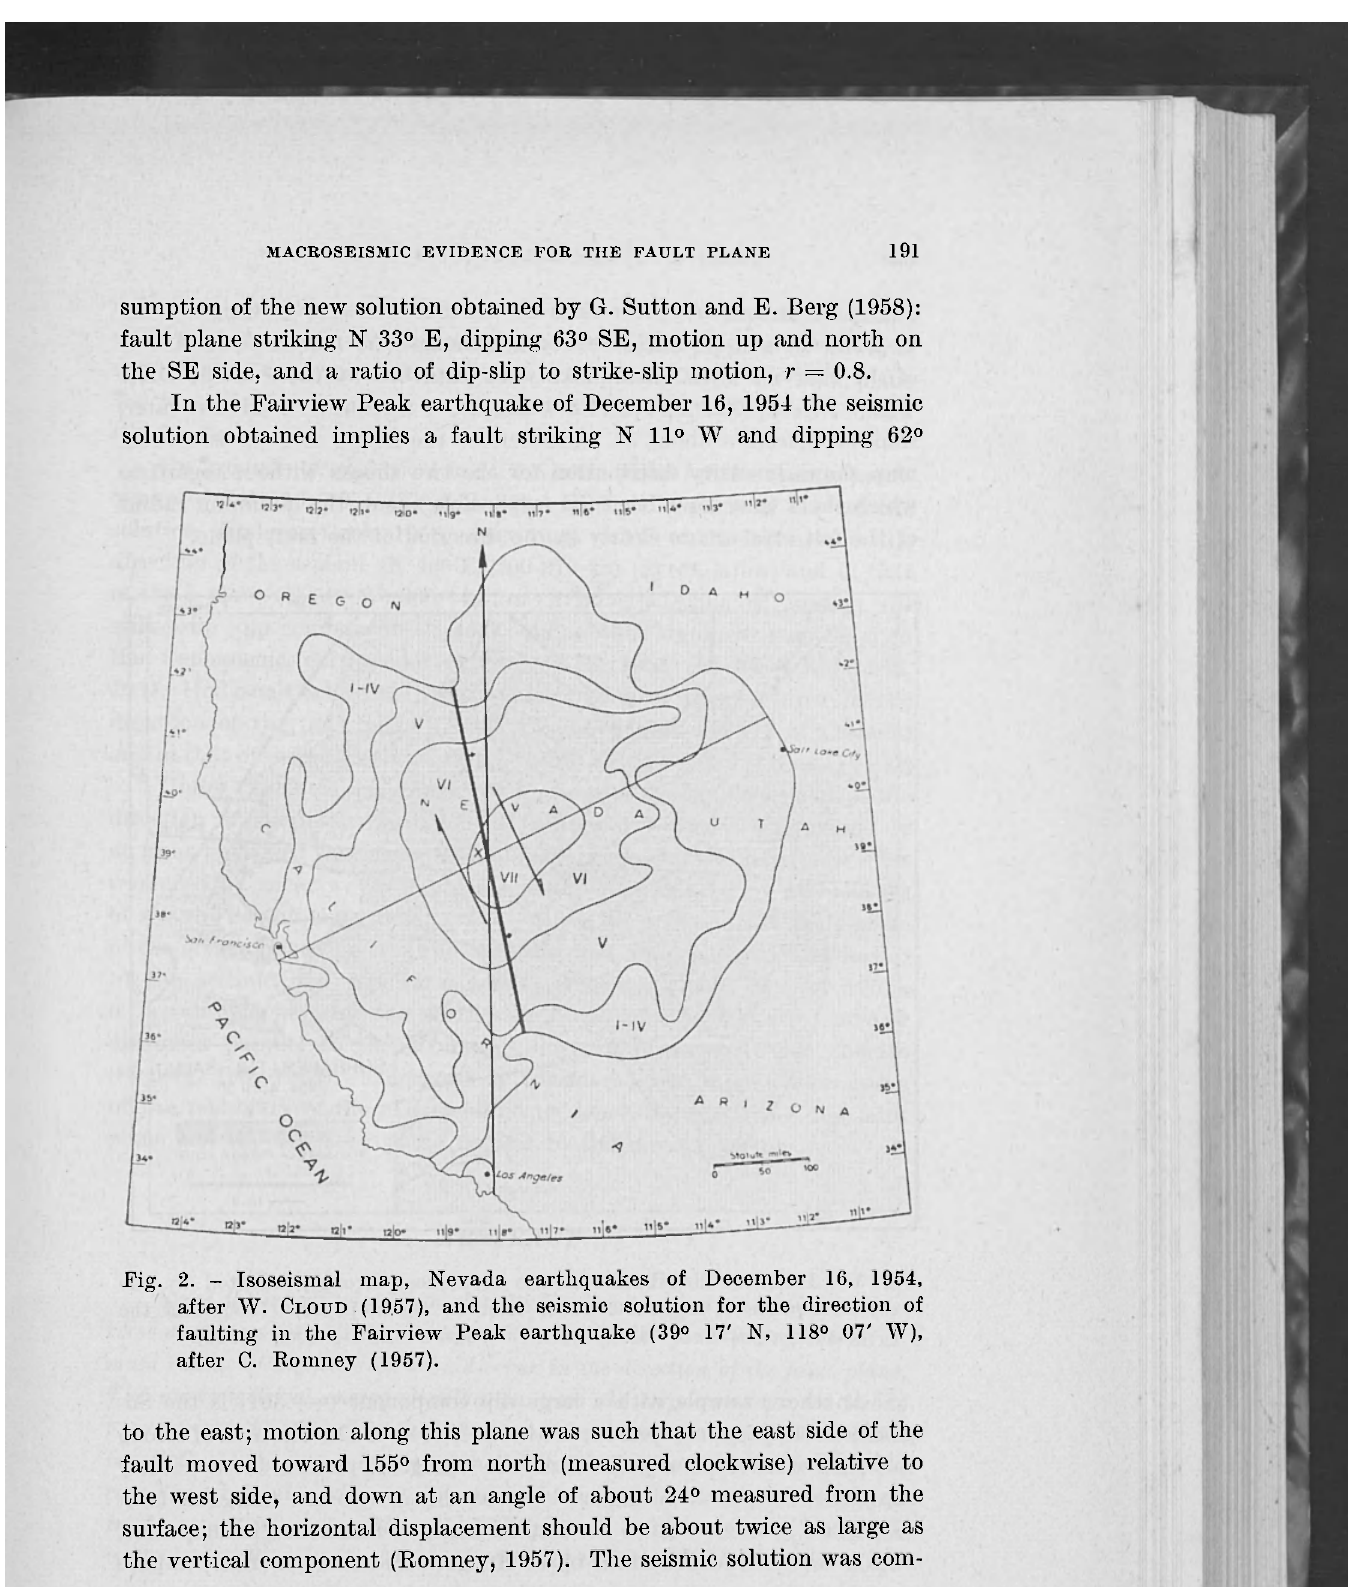
Fig. 2. - Isoseismal map, Nevada earthquakes of Deeember 16, 1954, after W. CLOUD (19.57), and the seismic solution for the direction of faulting in the Fairview Peak earthquake (39° 17' N, 118° 07' W), after C. Romney